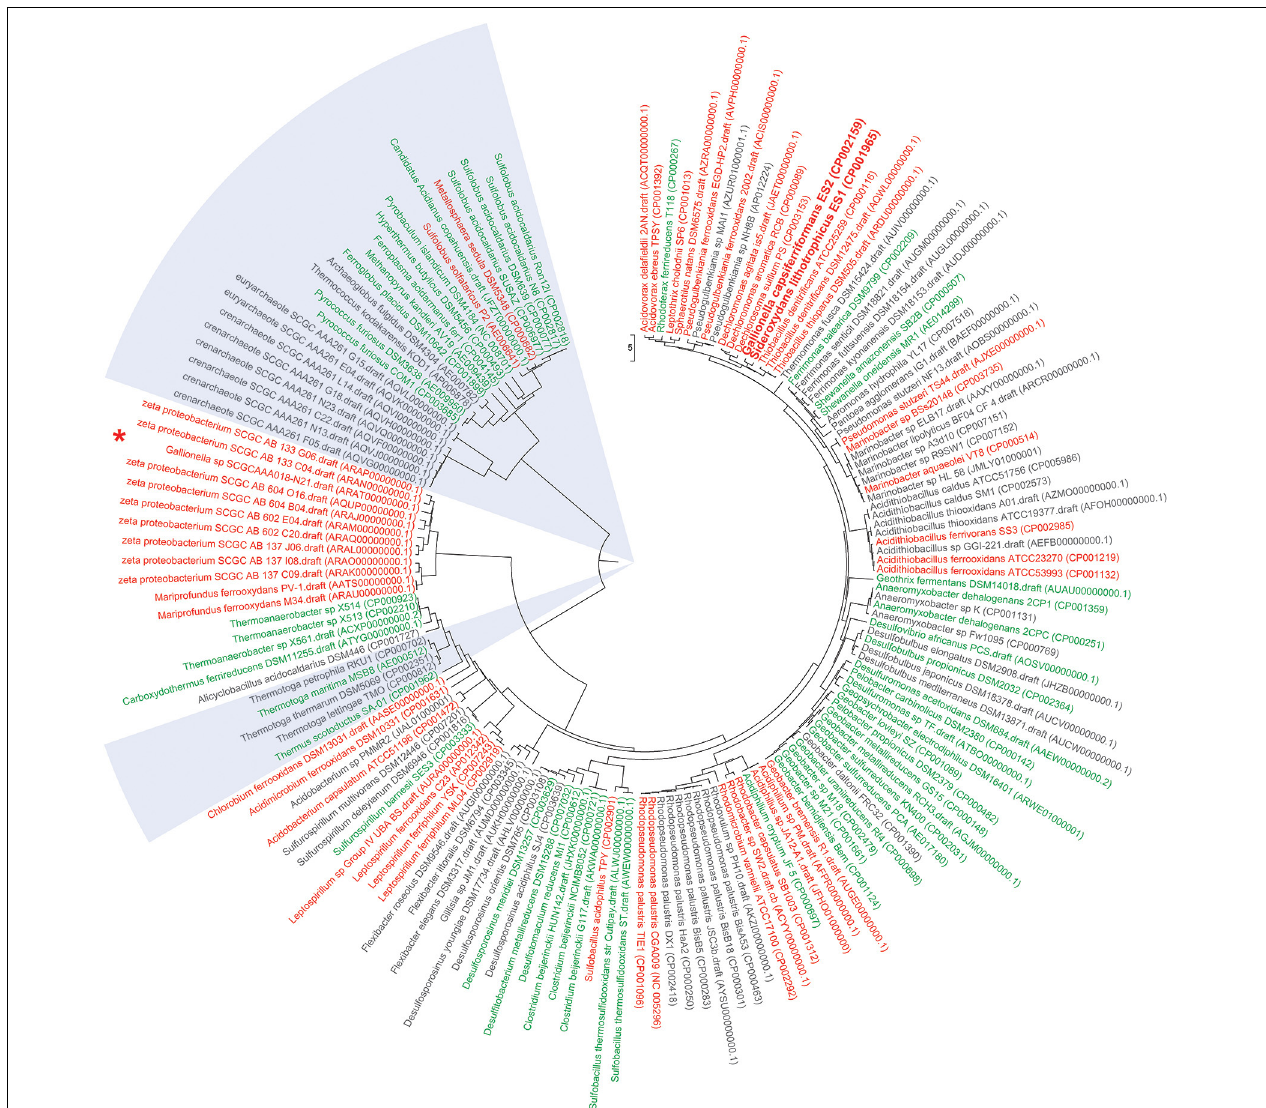
FIGURE 1 | Functional Genome Distribution Tree of iron oxidizing and iron reducing microbes. 158 genomes of publicly available known (and predicted) iron oxidizing and iron reducing bacteria and archaea were included into a Functional Genome Distribution (FGD) analysis (Altermann, 2012). Briefly, draft genomes were downloaded in FASTA format, concatenated and their respective gene models predicted through an updated version of the GAMOLA annotation pipeline (Altermann and Klaenhammer, 2003). Complete genomes were downloaded in Genbank format. All 158 genomes were then subjected to an FGD analysis using the compACTor software. Briefly, within an FGD analysis complete ORFeomes are compared to each other, providing a snapshot of genome-to-genome similarities, rather than an ancestral outlook. In summary, the 158 genomes comprised 501,624 open reading frames (ORFs) and a total of 79,881,099 individual BLAST analyses were carried out to calculate the level of similarities between all genomes. The resulting dissimilarity matrix was then visualized in Mega6 (Tamura et al., 2013) using the UPGMA algorithm to infer a dissimilarity tree. The early draft sequence of Leptothrix ochracea L12 was found to be too incomplete and was removed from the final tree. Iron oxidizing bacteria and archaea are shown in red; iron reducing bacteria (FeRB) and archaea (FeRA) are depicted